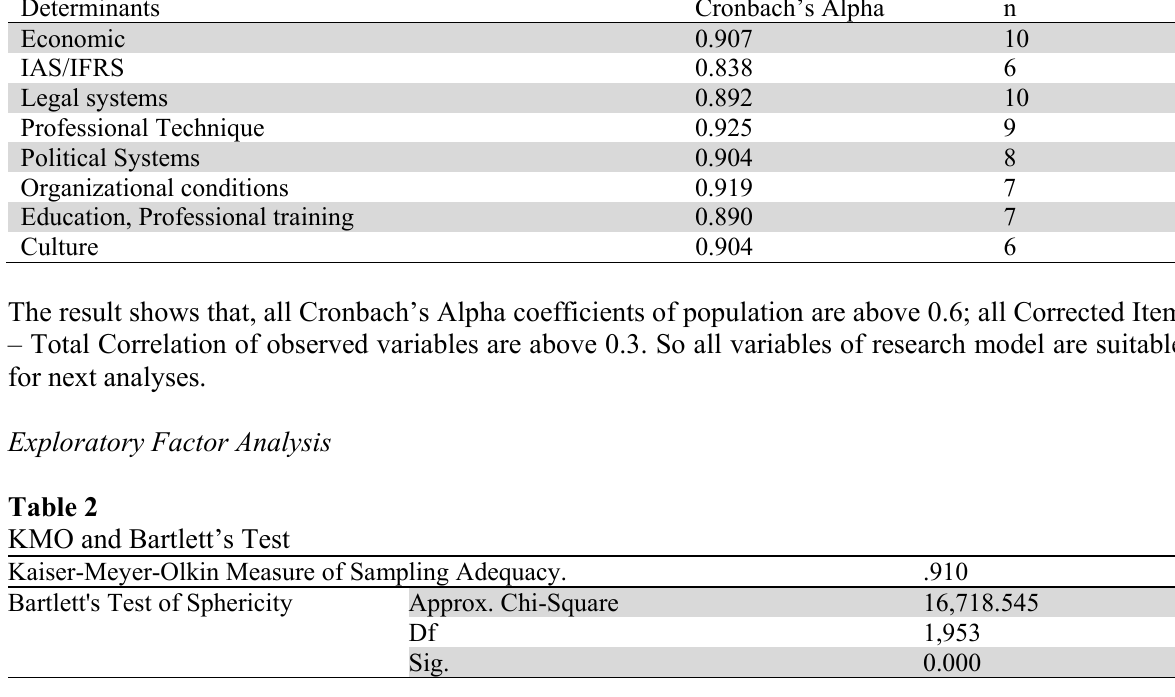
Results of Testing of Factors Confidence of Scales in the Model Determinants